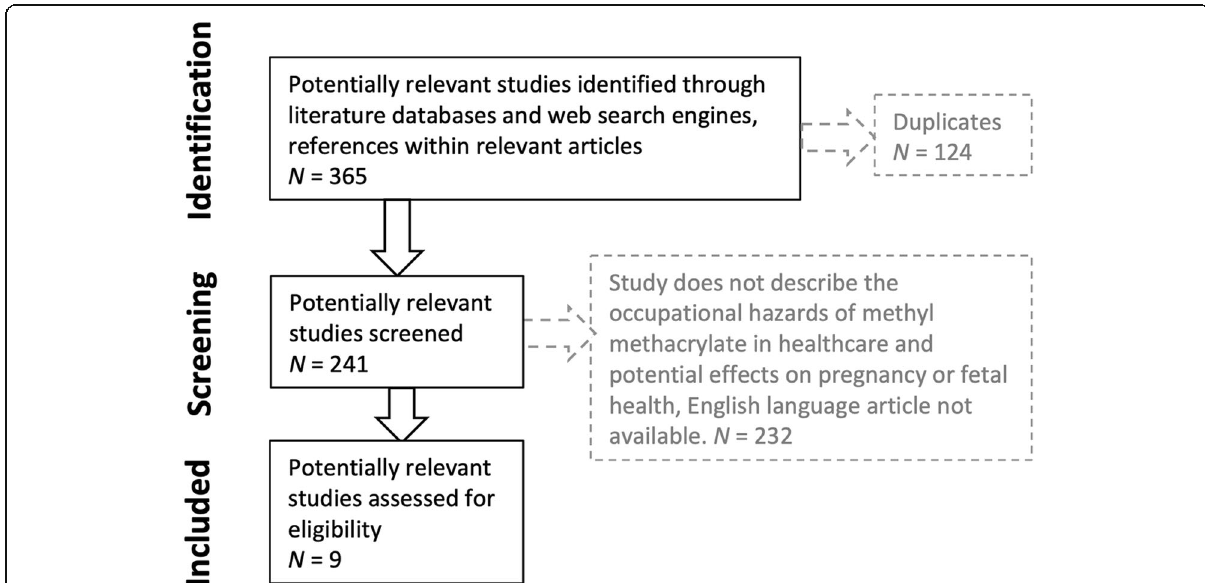
Fig. 1 Search strategy according to PRISMA (Preferred Reporting Items for Systematic Reviews and Meta-Analyses) guidelines. Nine studies were identified for